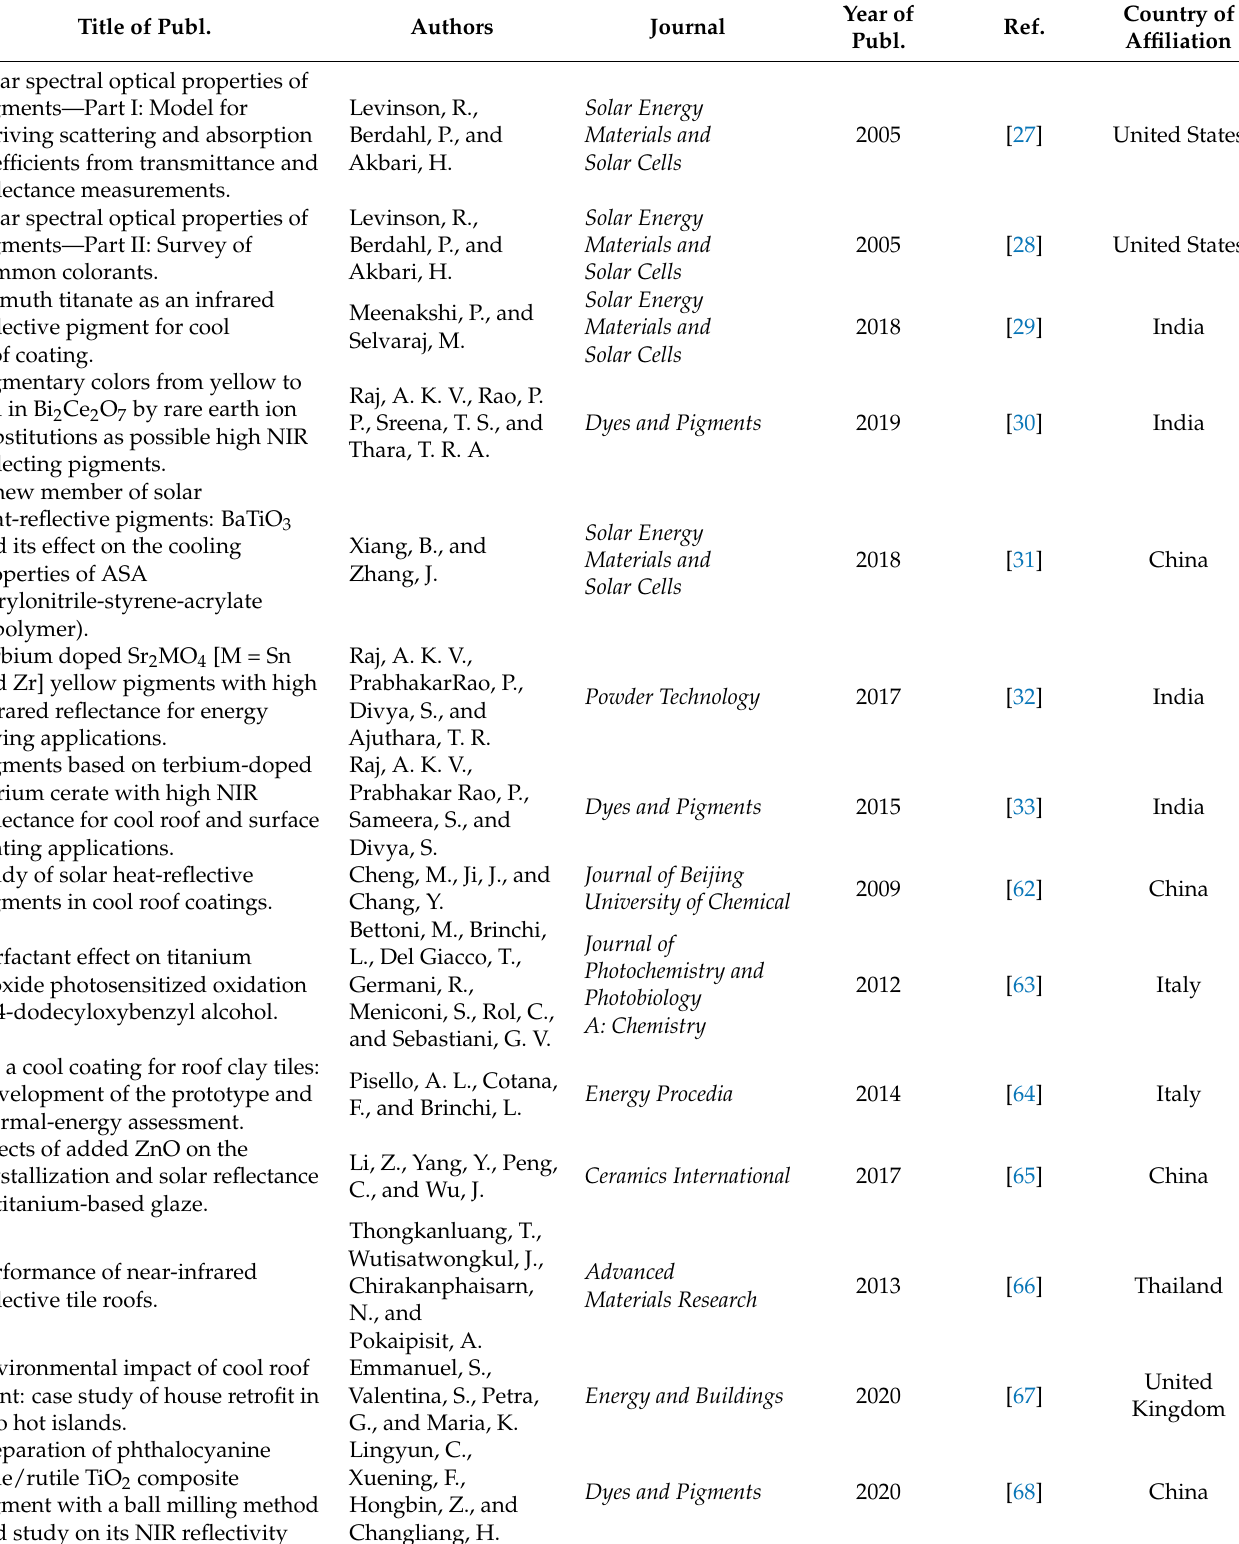
Table 1. Most important publications about